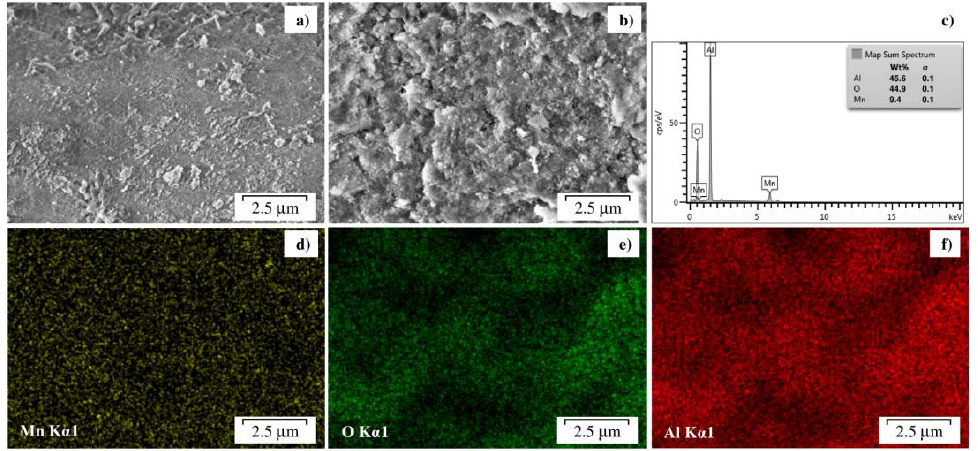
Figure 1. SEM micrographs of ( a ) the parent alumina and ( b ) the Mn/Al 2 O 3 catalyst; ( c ) EDX spectrum and the elemental distribution maps of ( d ) Mn, ( e ) O and ( f ) Al for the Mn/Al 2 O 3 catalyst.